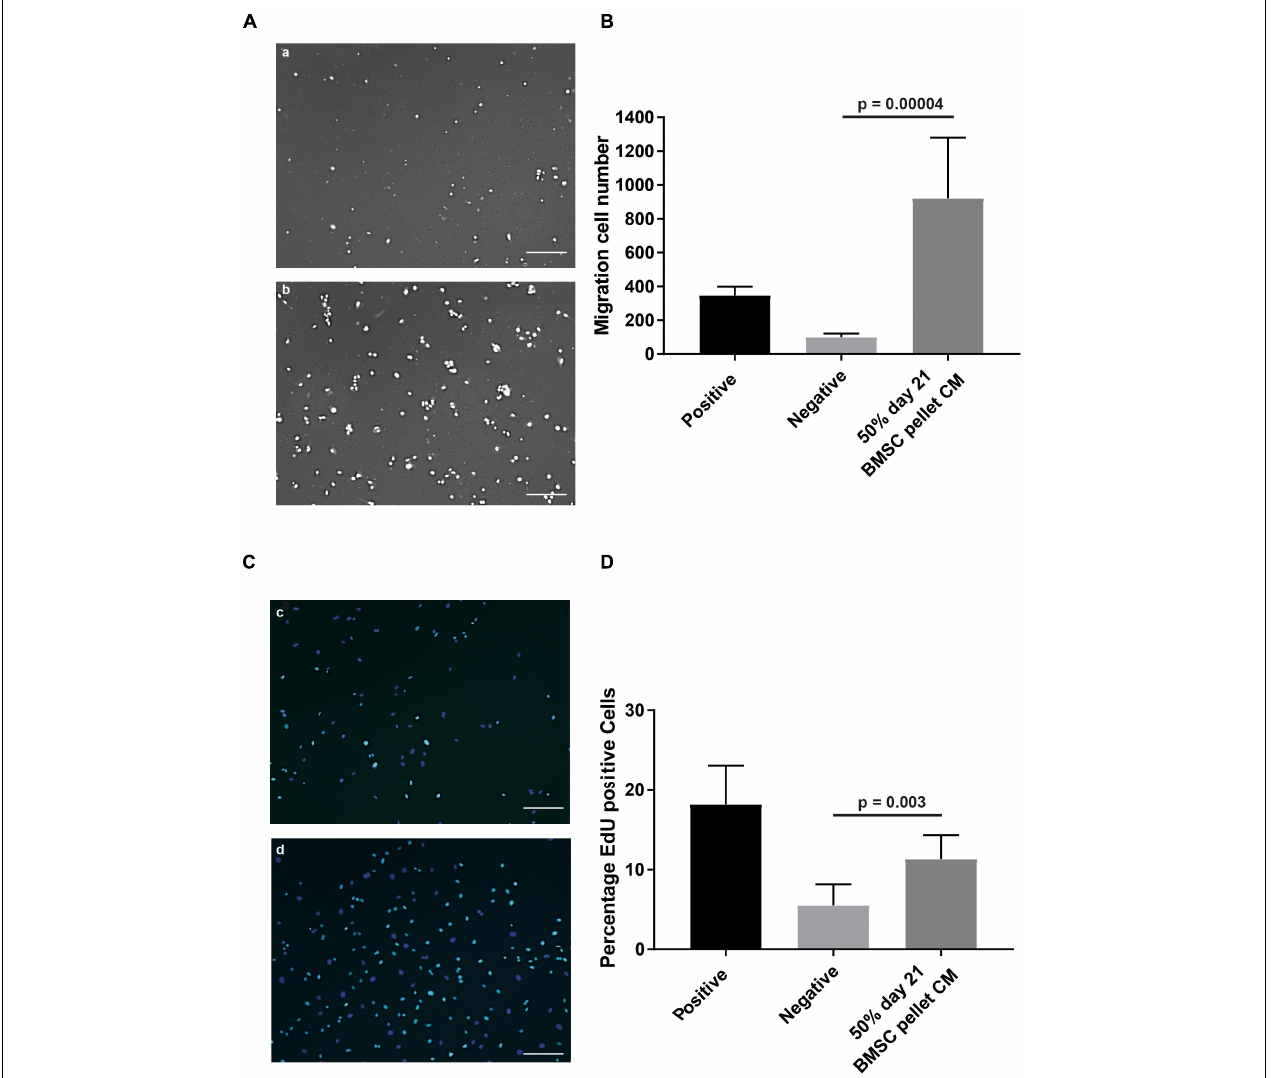
FIGURE 2 | In vitro angiogenesis assays confirmed pro-angiogenic potential of CM of chondrogenically differentiated BMSCs in pellets. (A) Modified Boyden chamber endothelial migration assay images; (a) Negative control, 50% endothelial basal medium and 50% non-CM; (b) positive control, endothelial growth medium. (B) Quantification of amount of migrated cells stimulated by the CM. (C) Endothelial proliferation assay; (c) negative control; (d) positive control showing in cyan positive EdU staining, counterstained with DAPI (blue). (D) Quantification of difference in actively proliferating HUVECs after 24 h. Both experiments were performed in two batches each pooling 3 donors; n = 3. Scalebar = 200 µ m, Statistical analyses were performed with mixed-linear model with Bonferroni post hoc test.